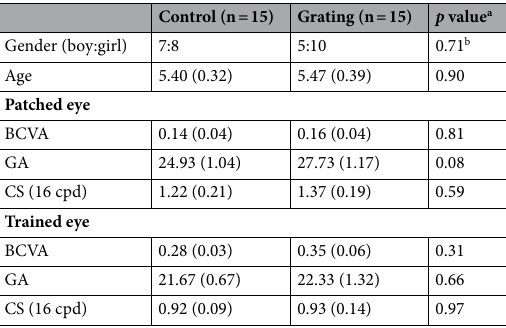
Table 1. Basic characteristics in patched and trained eyes of the control and Grating groups. Data are expressed as mean (standard error of mean). BCVA = best-corrected visual acuity; cpd = cycles per degree; CS = contrast sensitivity; GA = grating acuity. a Student t test. b χ 2 test.